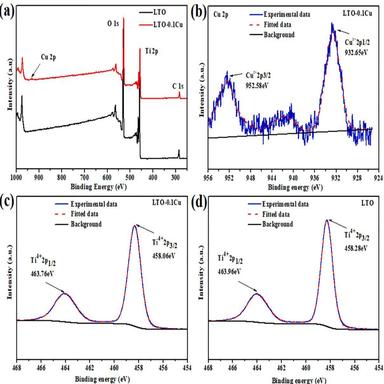
(a) XPS spectra of the LTO-0.1Cu composite and LTO samples. (b) High-resolution XPS spectra of Cu2p for LTO-0.1Cu composite. High-resolution XPS spectra of Ti2p for LTO-0.1Cu (c) and LTO (d) composite.